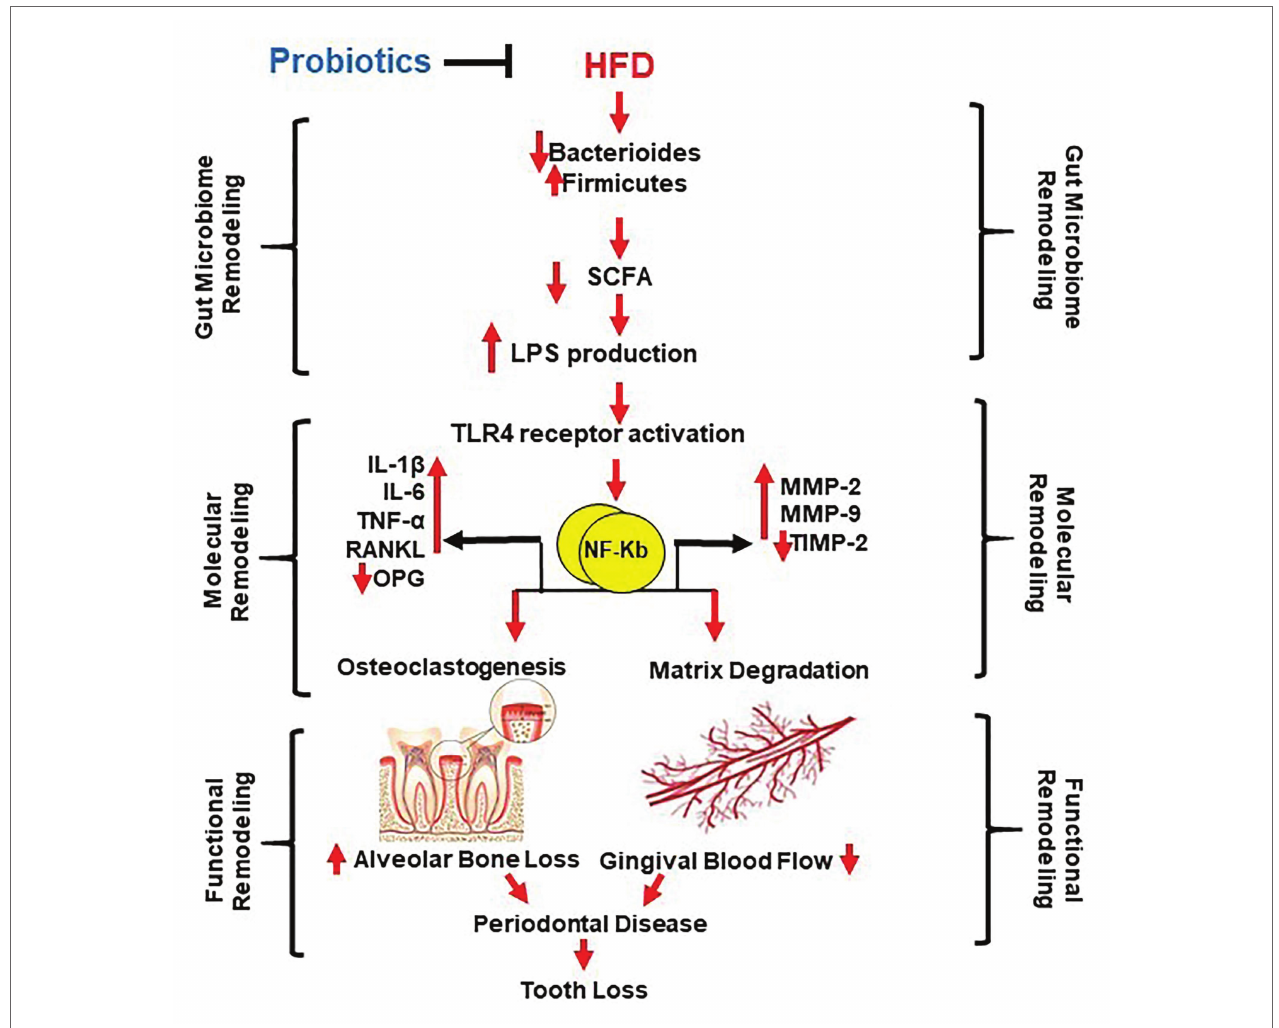
FIGURE 1 | Schematic representation of the study aim. High fat diet (HFD) causes gut dysbiosis ( via decreased short chain fatty acids (SCFA) and Bacteroides, and increased Firmicutes and Proteobacteria) resulting in increased lipopolysaccharide (LPS) production and LPS/TLR4 pathway activation in the oral cavity and gastrointestinal tract. Consequently, molecular remodeling occurs by increasing proinflammatory cytokines (IL-1 β , IL-6, and TNF- α ) and matrix metalloproteinases (MMP-2 and MMP-9). Due to the mentioned consequences, functional remodeling occurs, by an increase of proinflammatory cytokines, RANKL, and the decrease of OPG. Osteoclastogenesis and alveolar bone loss are promoted by disturbance in expression and activity of MMPs, matrix degradation, and gingival blood flow. This together cause periodontal disease and possibility of tooth loss. Probiotics maids mitigate all these